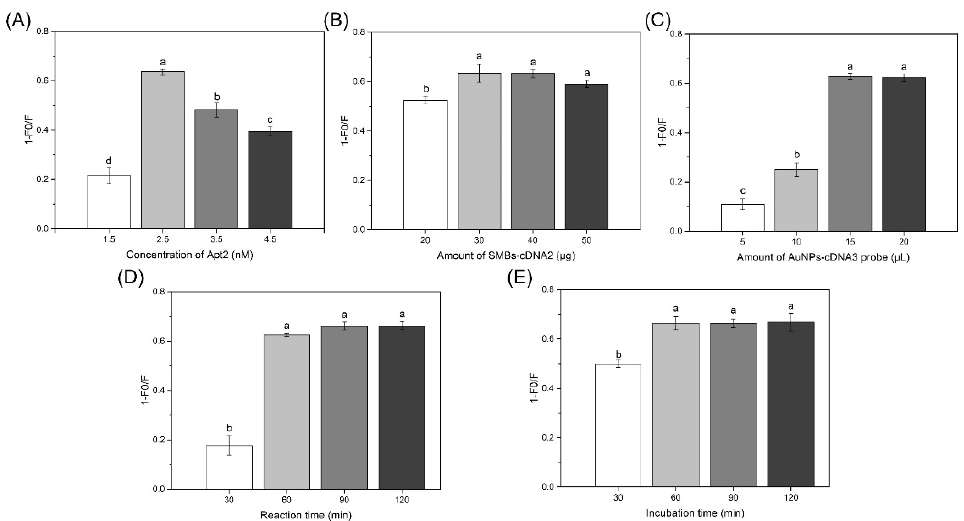
Figure 4. Optimization of trial conditions. ( A ) Concentration of aptamer. ( B ) Amount of SMBs- cDNA1 complex. ( C ) Amount of AuNPs-cDNA2 probe. ( D ) Reaction time between the SMBs- cDNA1 complex, the aptamer, and the AuNPs-cDNA2 probe (SMBs-Apt-AuNPs). ( E ) Incubation time of SMBs-Apt-AuNPs with S. Typhimurium. The error bars show the standard deviations of 3 replicates. Different lowercase letters indicate significant differences ( p < 0.05). The concentration of S. Typhimurium was tested at 10 6 cfu/mL.